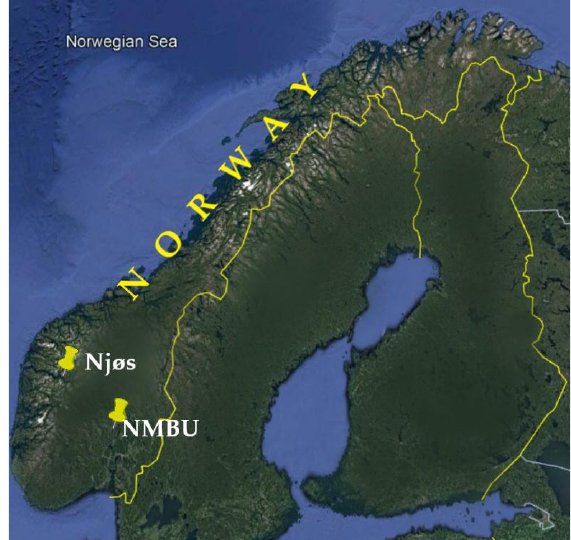
Figure 1. Sampling sites in Norway; Njøs Fruit and Berry Center and University of Life Science (NMBU).